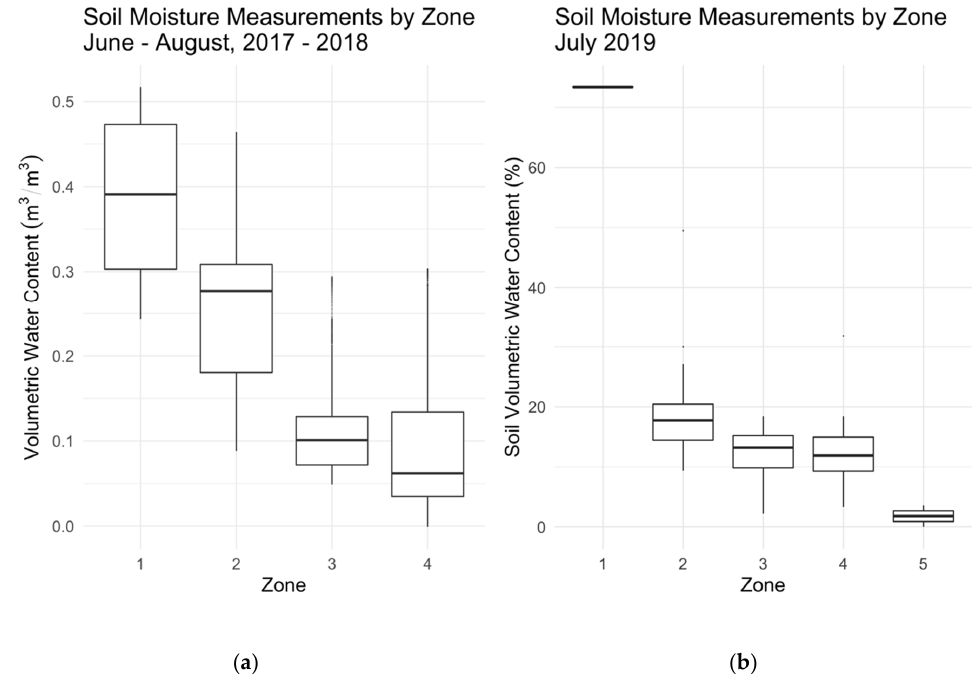
Figure 12. Soil moisture as a function of zones derived from Ward method clustering of NDVI time series: ( a ) hourly continuously measured soil moisture sensor data at 50–60 cm depth (20 sensors) from June 1–August 10 in 2017 and 2018 and ( b ) one-time TDR point-probe measurements at 25 cm depth (60 locations) in July 2019. In ( a ), there were 3 sensors measuring hourly volumetric water content in Zone 1, 4 sensors in Zone 2, 5 sensors in Zone 3 and 8 sensors in Zone 4. Figure S3a,b displaying the time series of volumetric water content by zone are included in the supplementary materials. For the TDR measurements in ( b ), there were 2 samples taken in Zone 1, 20 in Zone 2, 20 in Zone 3, 16 in Zone 4 and 2 in Zone 5.